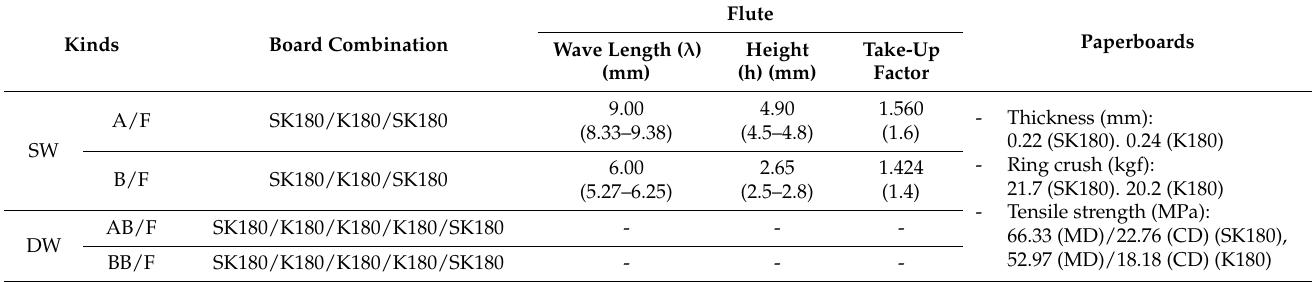
Table 1. Measured specifications of the corrugated paperboards used in the